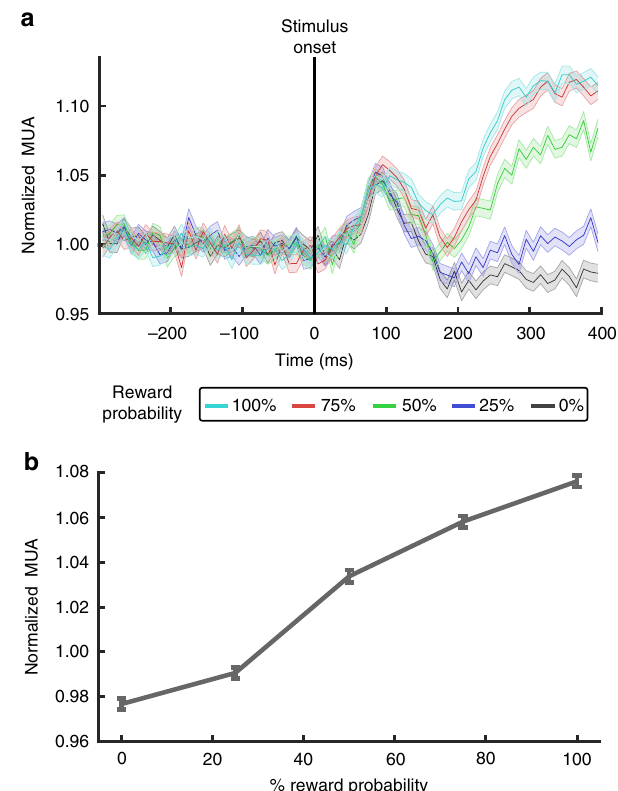
Fig. 1 Electrophysiological con fi rmation of prediction error